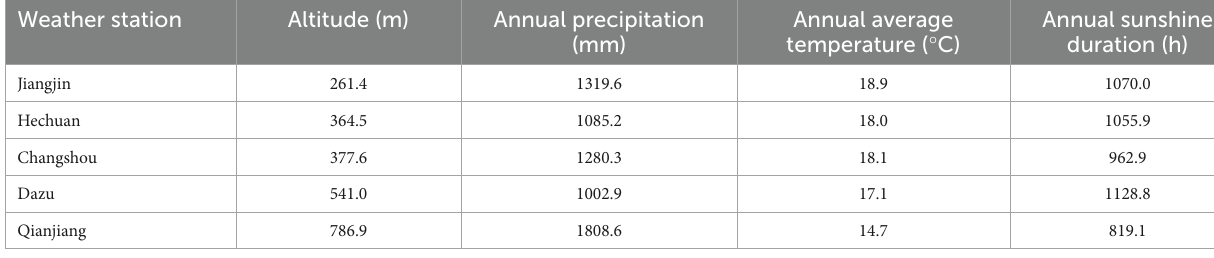
TABLE 1 The annual average temperature, annual precipitation, and annual average sunshine duration in Chongqing in